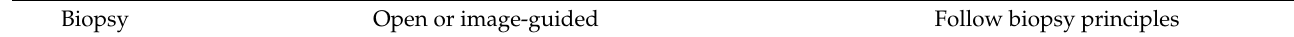
Table 1. Workup for unknown bone lesion in patients >40 years old.